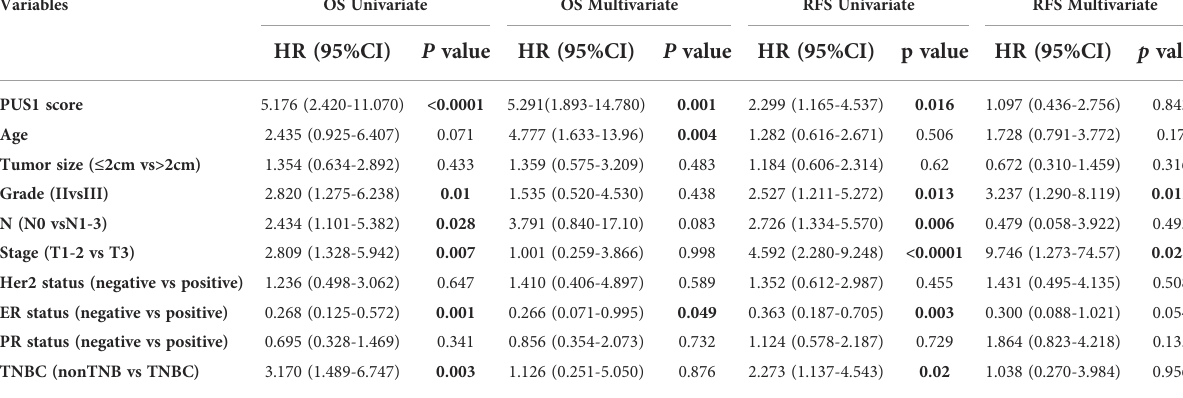
TABLE 2 Univariate and multivariate cox regression analysis of prognostic factors in breast cancer